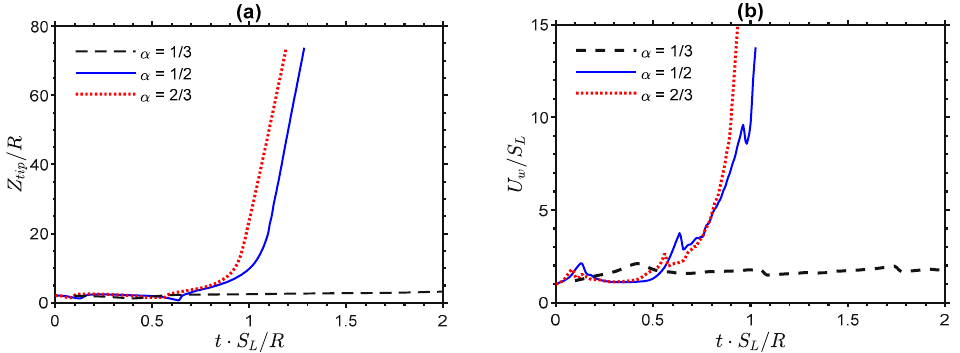
Figure 8. The scaled flame tip position Z tip / R ( a ) and the scaled burning velocity U w / S L ( b ) versus the scaled time τ = tS L / R for the Θ = 8 flame in the channels of half-width R = 48 L f with various blockage ratios α = 1/3, 1/2, 2/3 .